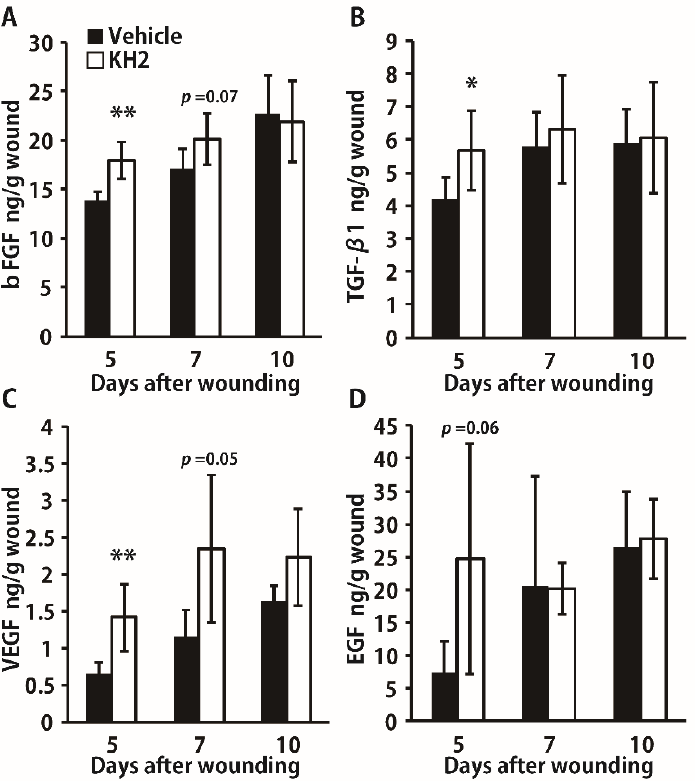
Figure 3. Effect of heat-killed KH2 administration on the production of bFGF, TGF- β 1, VEGF, and EGF. ( A ) Production of bFGF in the homogenates of wound tissues was measured on days 5, 7, and 10 after wound creation ( n = 5–6 mice). ( B ) Production of TGF- β 1 in the homogenates of wound tissues was measured on days 5, 7, and 10 after wound creation ( n = 5–6 mice). ( C ) Production of VEGF in the homogenates of wound tissues was measured on days 5, 7, and 10 after wound creation ( n = 5–6 mice). ( D ) Production of EGF in the homogenates of wound tissues was measured on days 5, 7, and 10 after wound creation ( n = 5–6 mice). Each column represents the mean ± standard deviation. The results are representative of at least two independent experiments. * p < 0.05, ** p < 0.01.